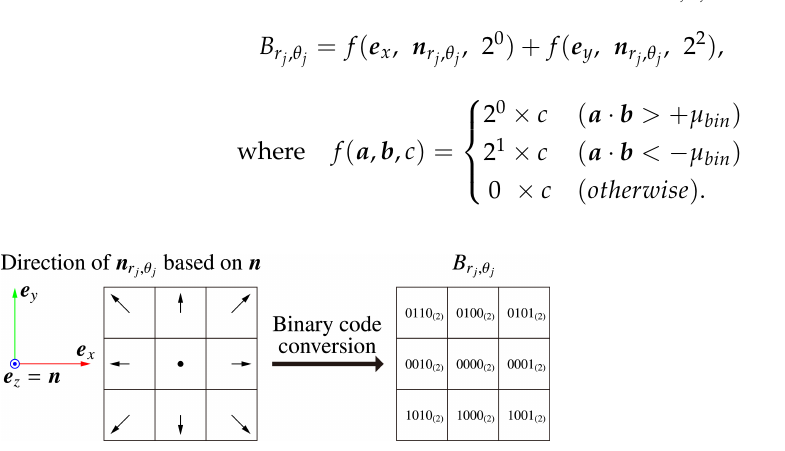
Figure 2. Binary codes based on the normal of the center